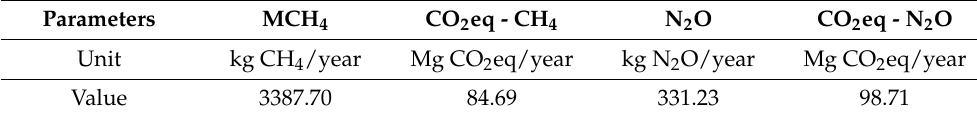
Table 4. Masses of methane and nitrous oxide and conversion to the equivalent of carbon dioxide.